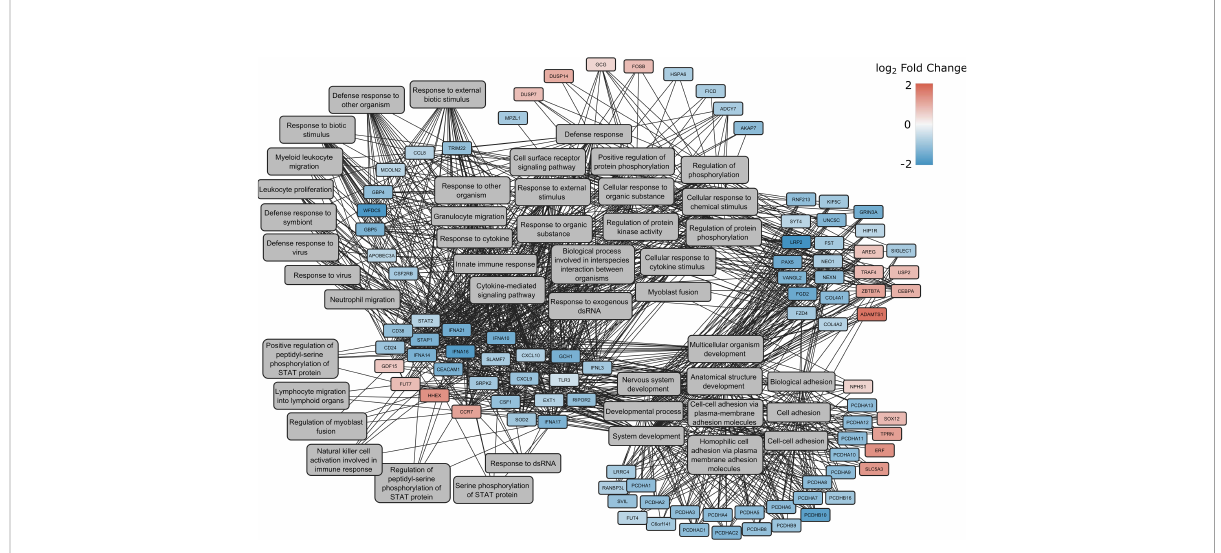
FIGURE 3 Enrichment network of DEGs between spike-transfected and mock-transfected samples in GO: Biological Processes. The log2(fold change) of the genes are indicated with red and blue colors, while involvement in a process is highlighted with gray lines connecting to the genes with the GO